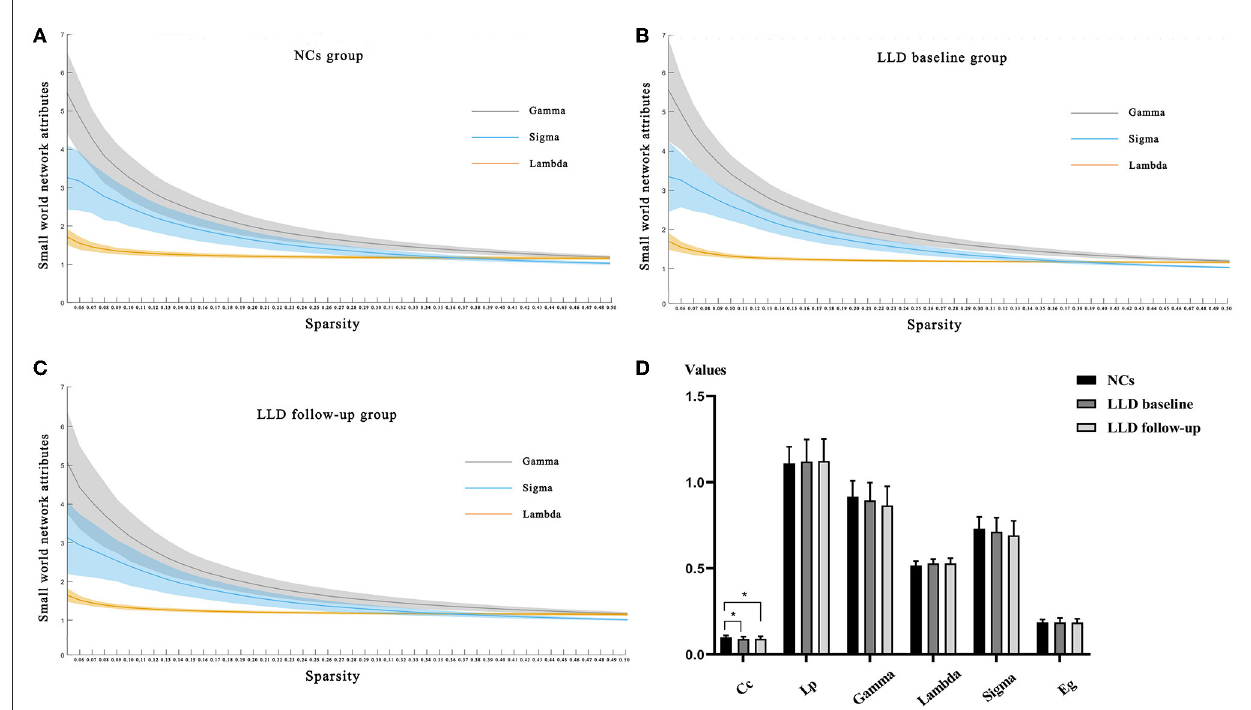
FIGURE3 Comparisons of global indicators of functional brain networks from the AAL160 template. (A) Small-world attribute indices of functional brain networks along with sparsity in the NCs group; (B) Small-world attribute indices of functional brain networks along with sparsity in the LLD baseline group; (C) Small-world attribute indices of functional brain networks along with sparsity in the LLD follow-up group; (D) Global attribute indicators of functional brain networks in LLD baseline group, LLD follow-up group and NCs group.